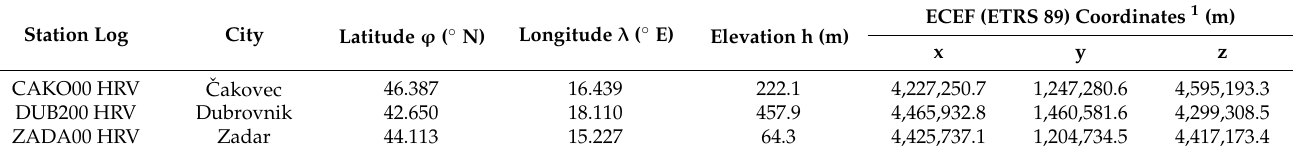
Table 1. General data from the EUREF measuring stations used (made by authors according to [43]). Station Log